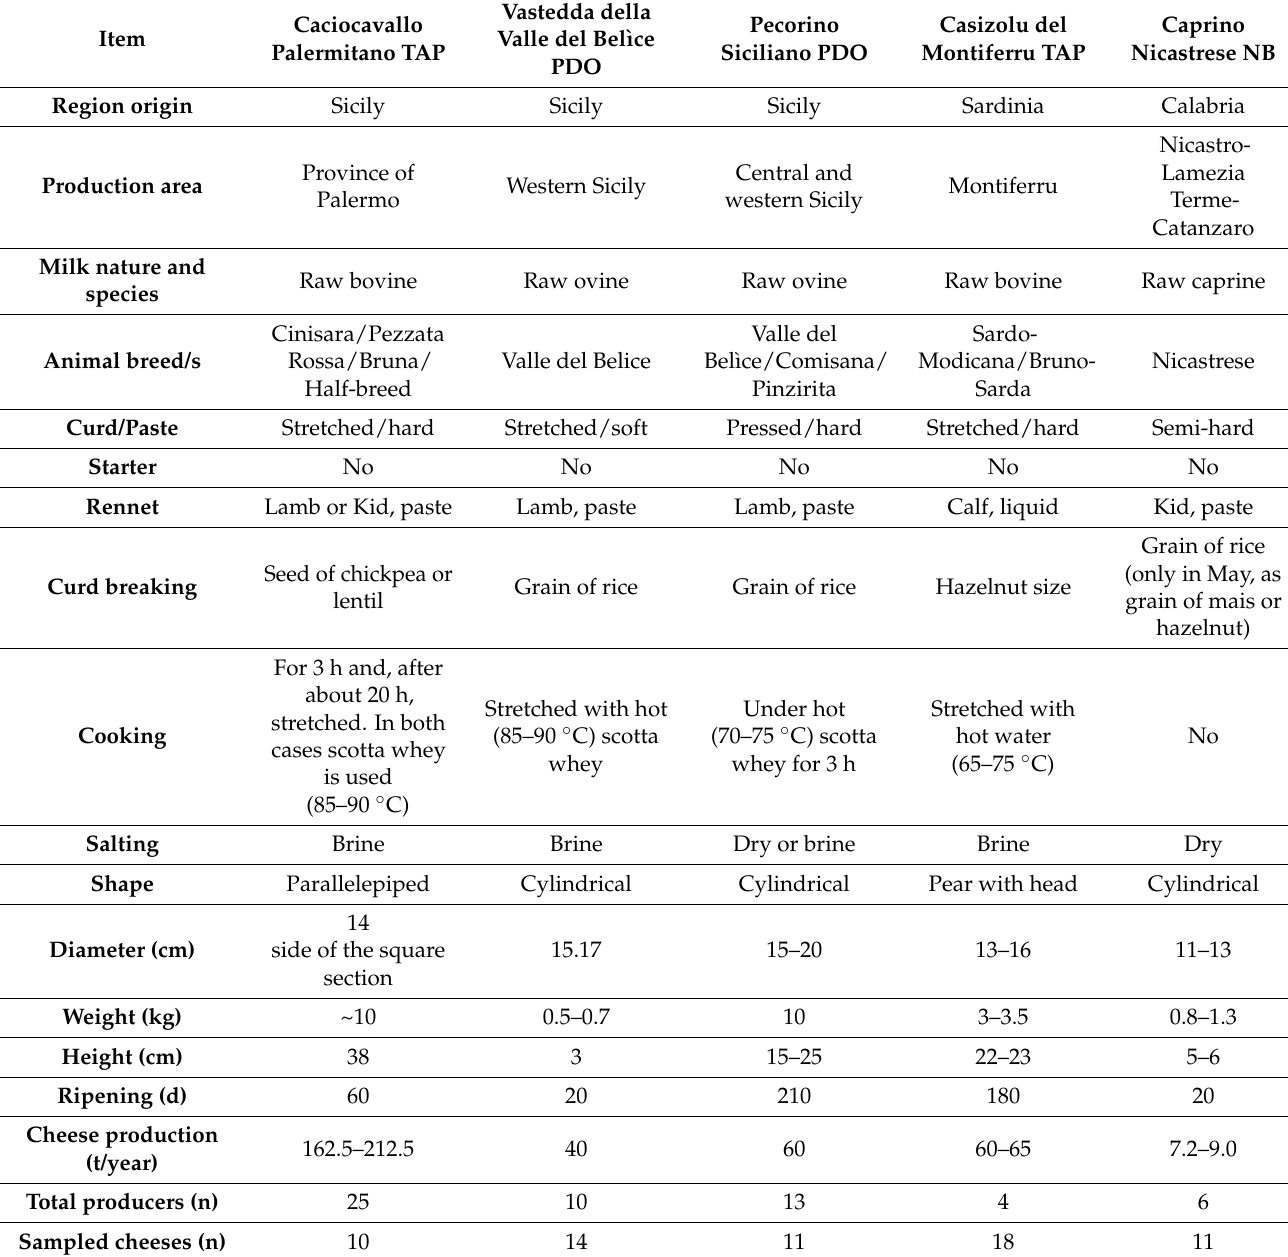
Table 1. Synthetic description of general characteristics of the AGER selection